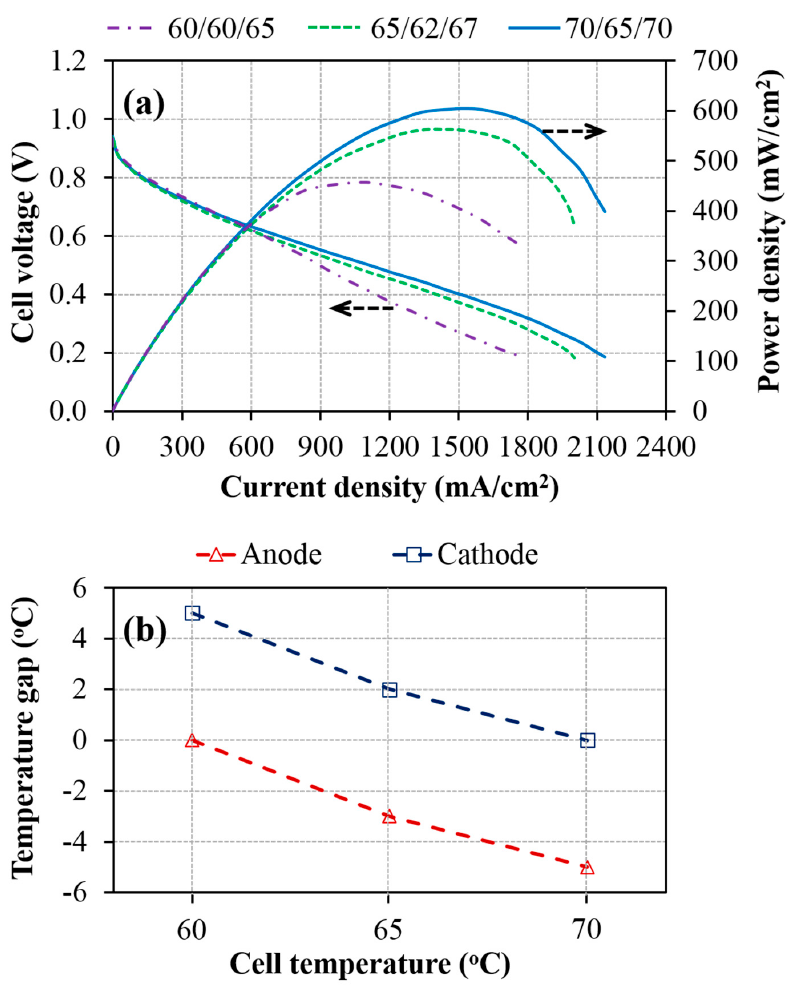
Figure 3. ( a ) Polarization and power density curves of AEMFCs operated at the cell temperatures of 60, 65, and 70 ◦ C with the optimized dew points of the anode / cathode inlet gases at 60 ◦ C / 65 ◦ C (60 / 60 / 65), 62 ◦ C / 67 ◦ C (65 / 62 / 67), and 65 ◦ C / 70 ◦ C (70 / 65 / 70), respectively; ( b ) Temperature gap between optimized dew points and cell temperature (The symbol of 60 / 60 / 65 denotes that the cell temperature and dew points of the anode and cathode are 60 ◦ C, 60 ◦ C, and 65 ◦ C, respectively).